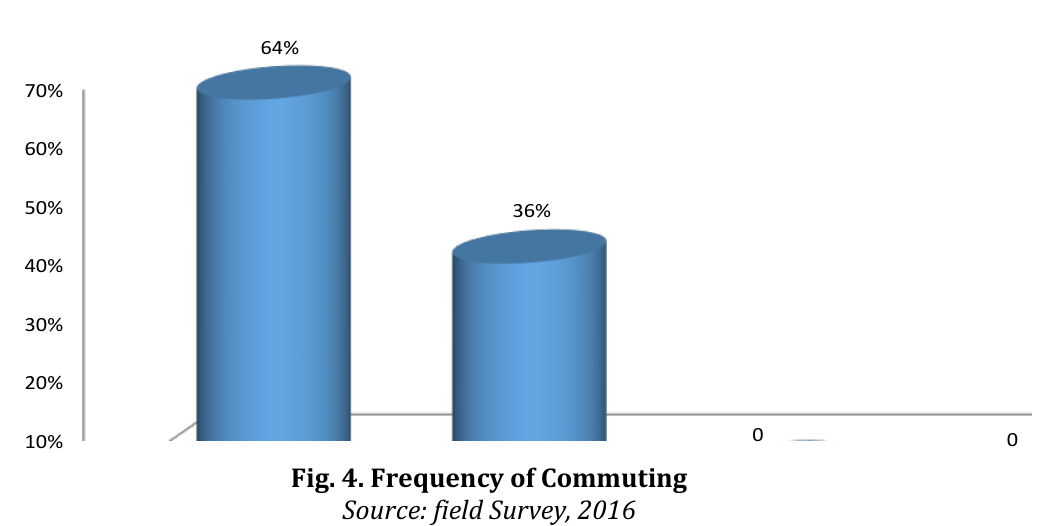
Fig. 4. Frequency of Commuting Source: field Survey,